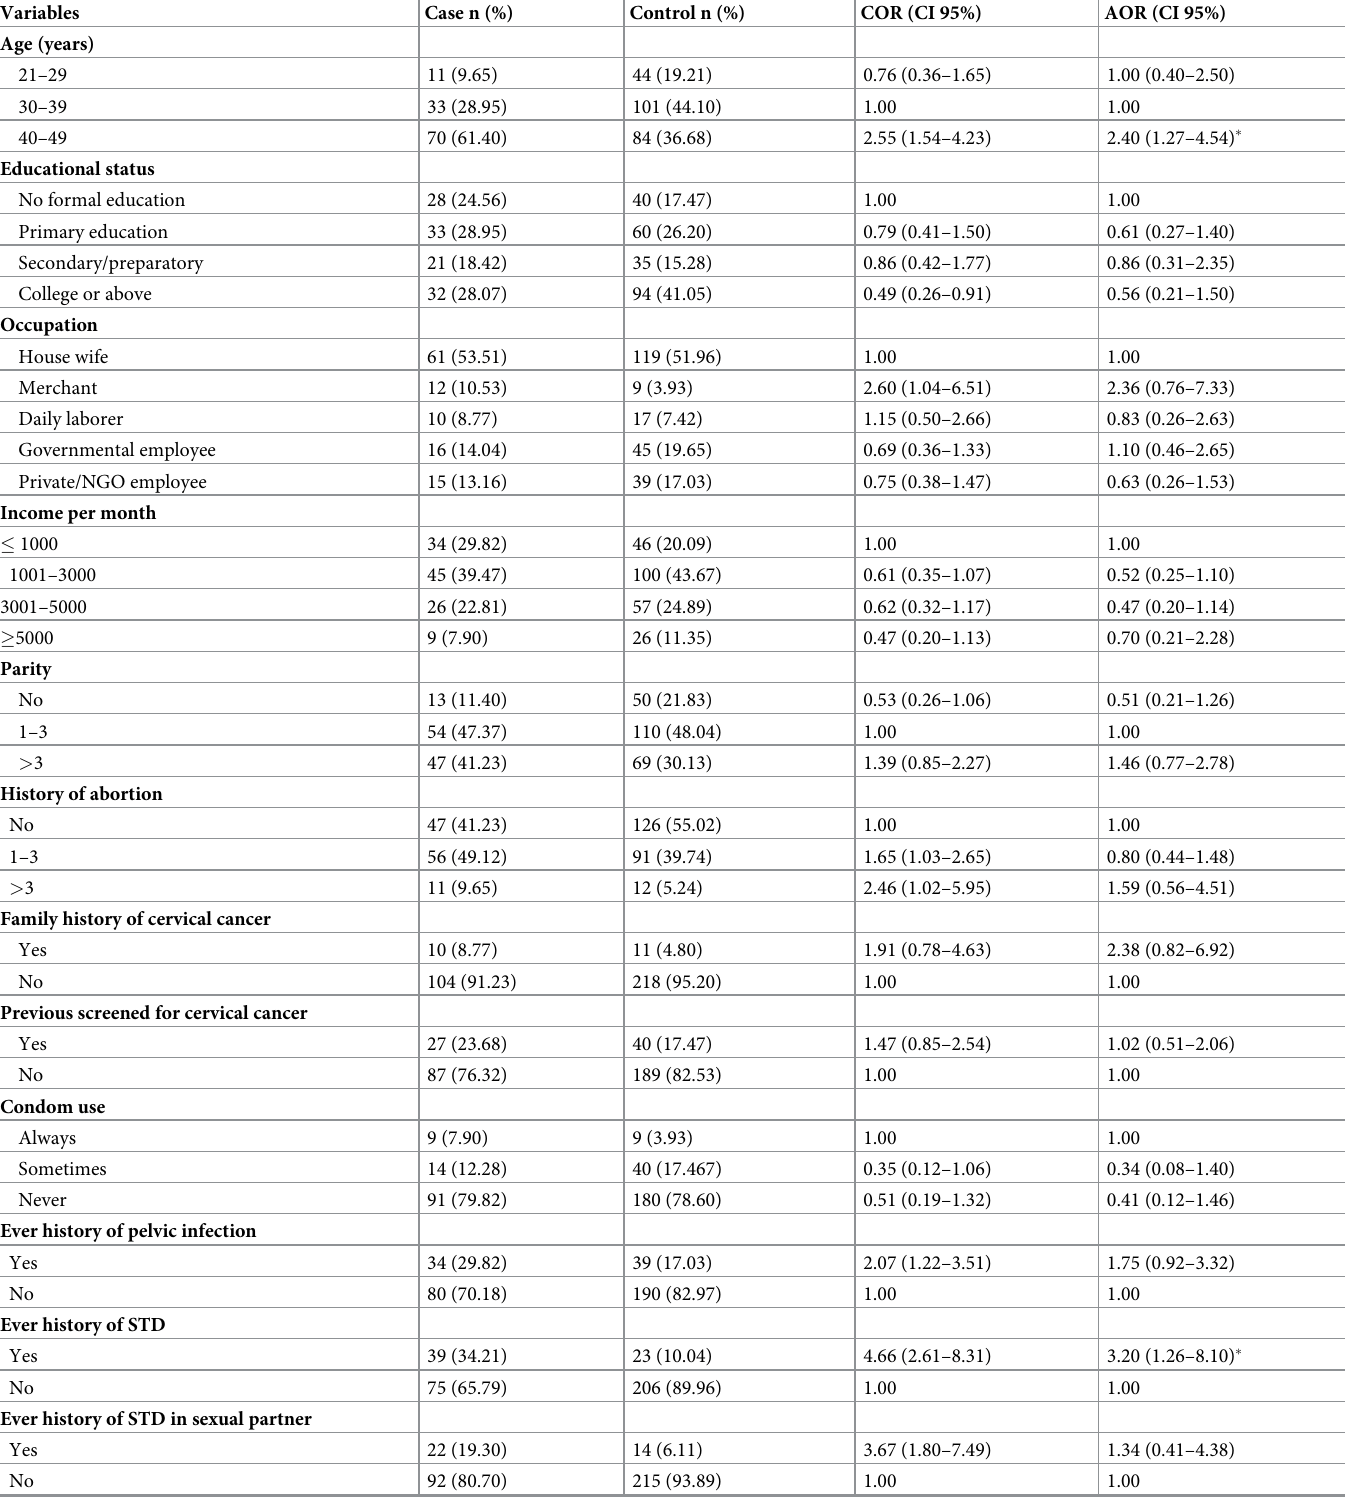
Table 4. Multivariate analysis of selected variables among study participants of Addis Ababa, Ethiopia,